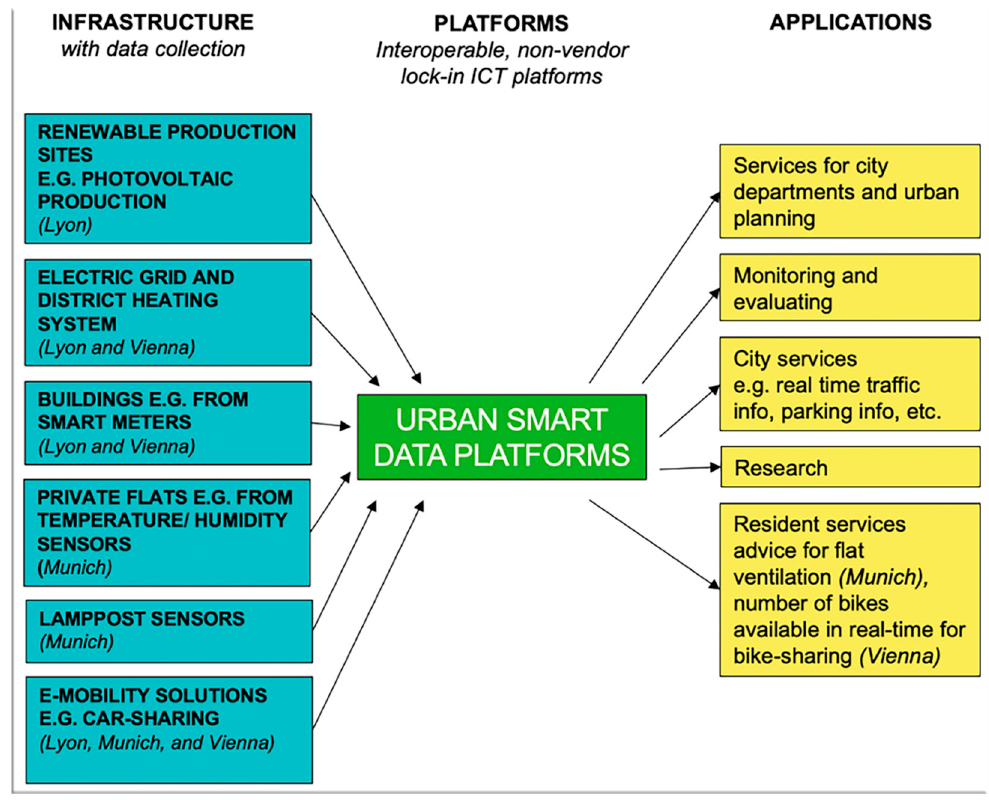
Figure 4. Data flow within the established data management platforms for the three LHCs. From left to right: Infrastructure components as inputs (turquoise), smart data platform repository and analysis (green), and applications as outputs (yellow).